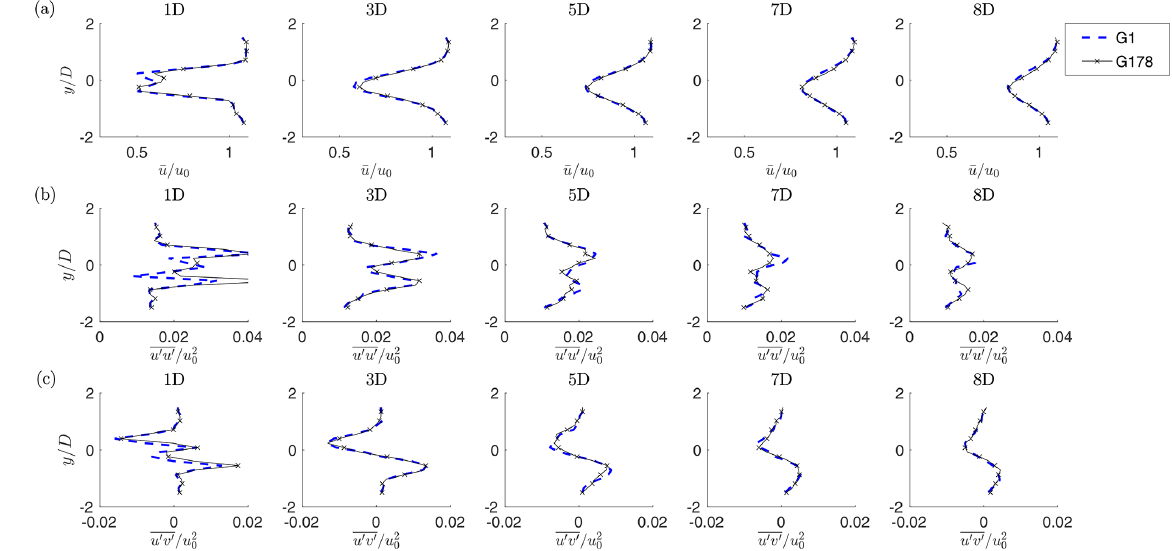
Figure 11. Hub-height profiles of normalized time-average streamwise velocity (a) and shear stresses (b, c) , in the misaligned and high-TI condition.